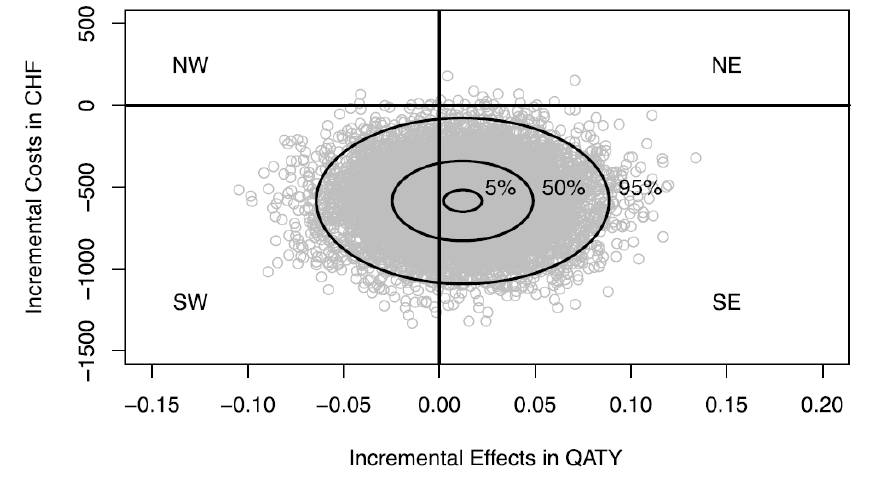
Figure 3. Joint distribution of incremental costs and effects on the cost-effectiveness plane. Mean Δ C − 584 Swiss Francs, mean Δ E 0.01 QATY (Quality-Adjusted Tooth-Year) from Zitzmann et al. (2013) [28]. The 95%, 50% and 5% credible ellipses are drawn. NW, North-West; SW, South-West; NE, North-East; SE, South-East.